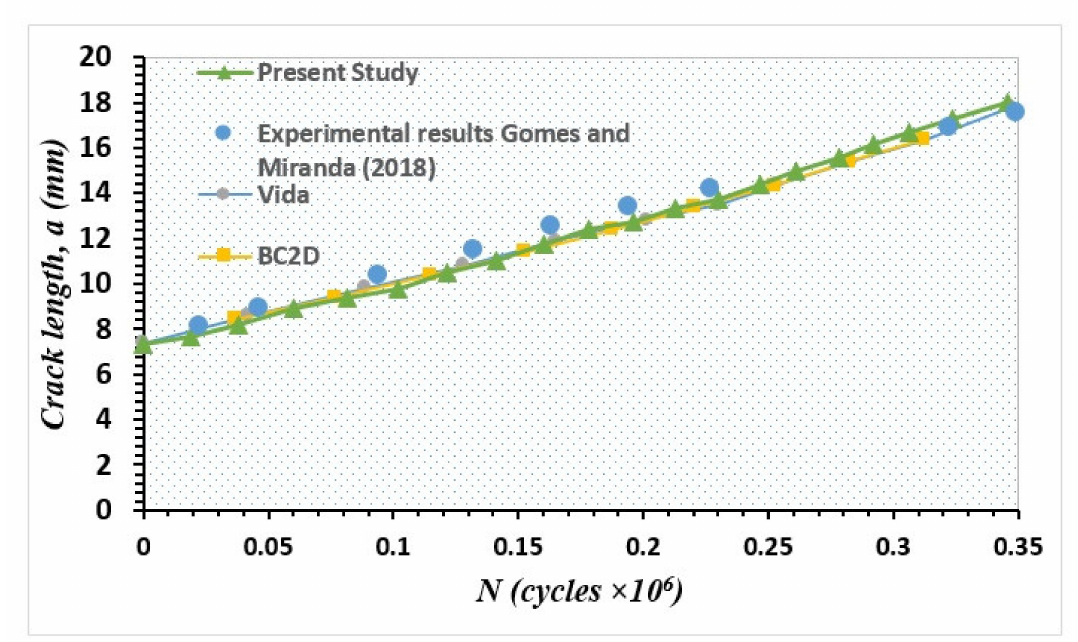
Figure 17. Fatigue life for the modified compact tension specimen CTS02.